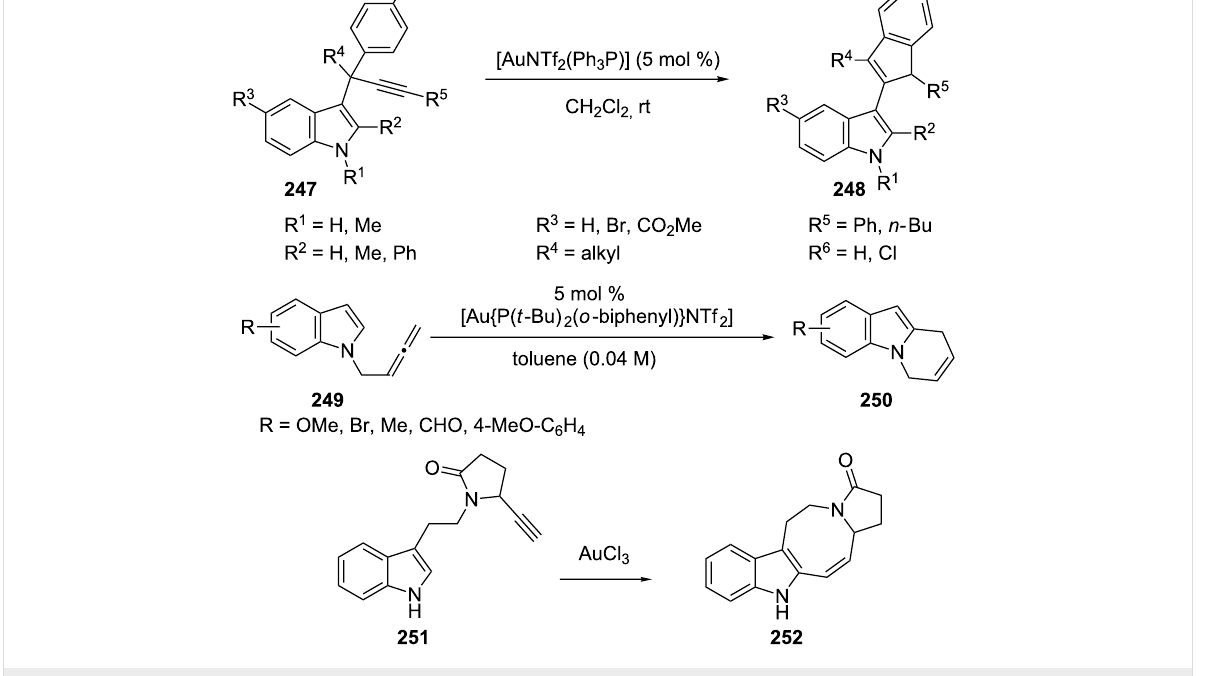
Scheme 45: Gold(I)-catalyzed cycloaddition of indoles.